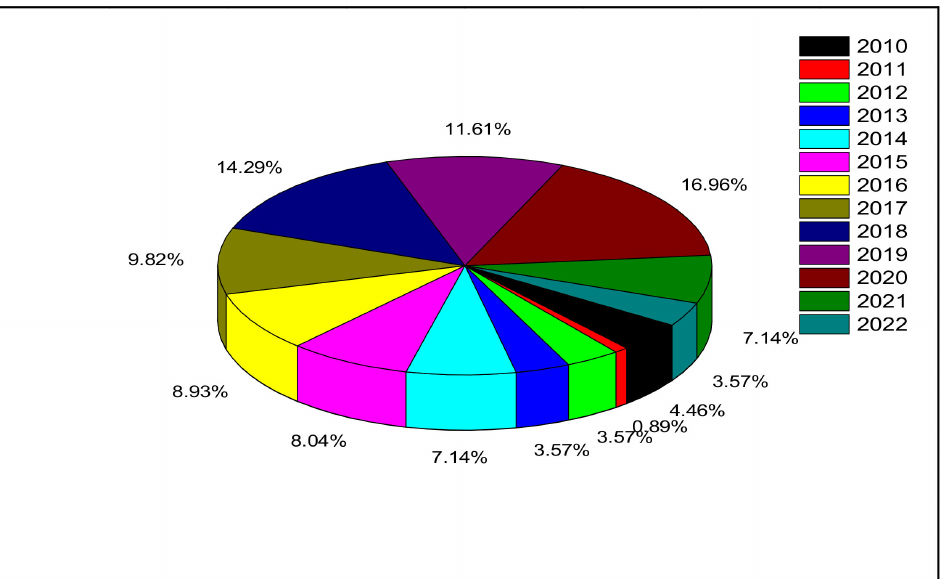
Figure 7. The number of published articles in the period between 2010 and